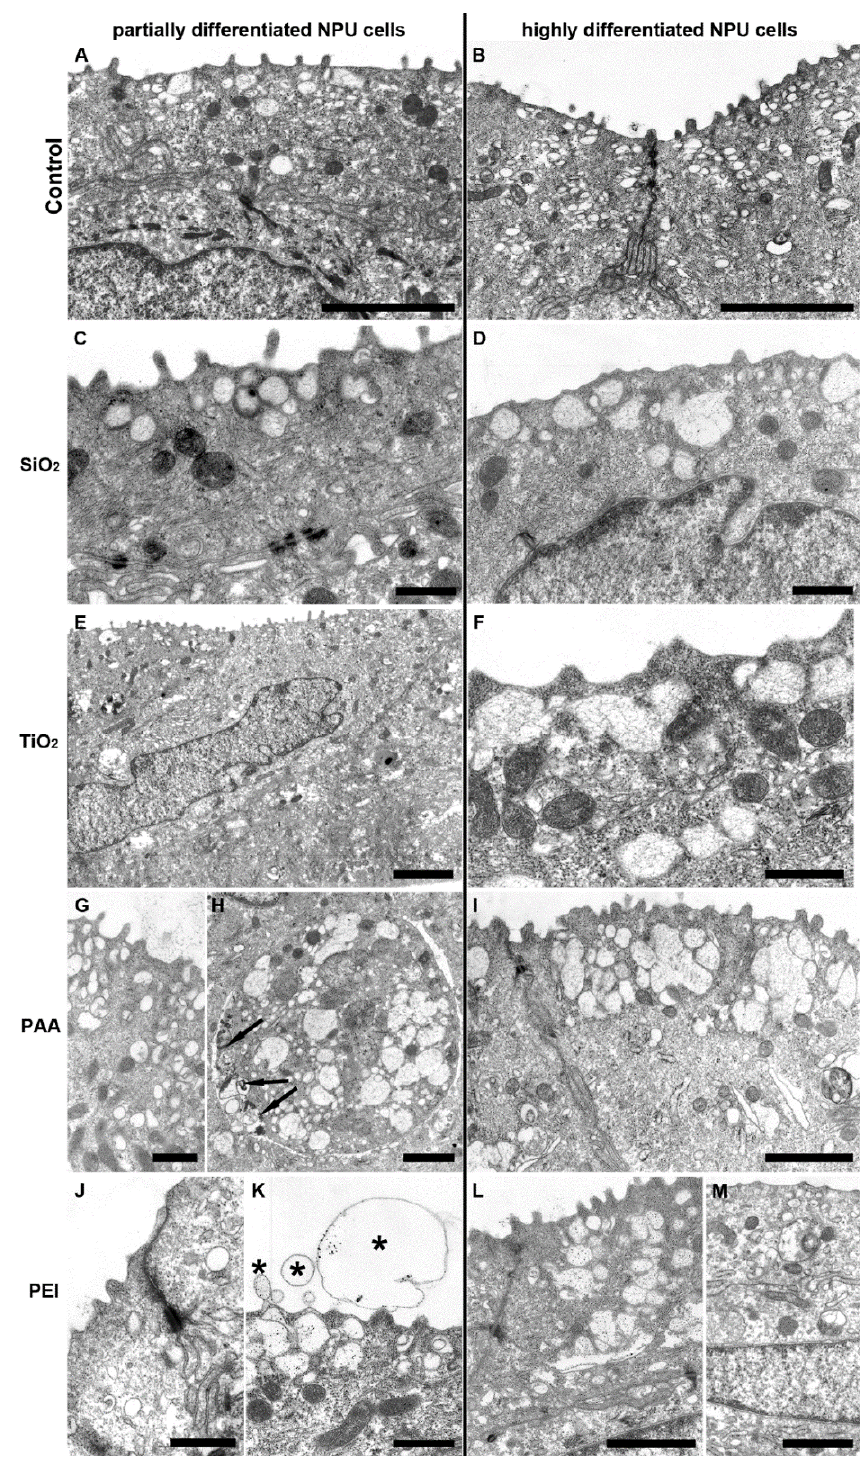
Figure 5. TEM images of partially differentiated and highly differentiated NPU cells after prolonged exposure to NPs. ( A , B ) Control, untreated NPU cells and NPU cells treated with ( C , D ) SiO 2 , ( E , F ) TiO 2 , ( G , H , I ) PAA (50 μ g/mL), and ( J – M ) PEI (2 μ g/mL) NPs for 31 days in continuous exposure experiment. In a partially differentiated NPU model, exfoliations of apical plasma membrane were found very rarely and only in PEI-treated cells (asterisks). Aggregates of the contrasting agent (arrows) and not PAA nanoparticles are seen in H. In NPU cells of partially and highly differentiated models, many fusiform vesicles are present in the apical cytoplasm and well-developed junctional complexes (tight junctions, adherent junctions, and desmosomes), which are specific morphological characteristics of urothelial cells, scale bars: 500 nm ( C , D , F , G , J , K ), 1 μ m ( H , I , L , M ), and 2 μ m ( A , B , E ).